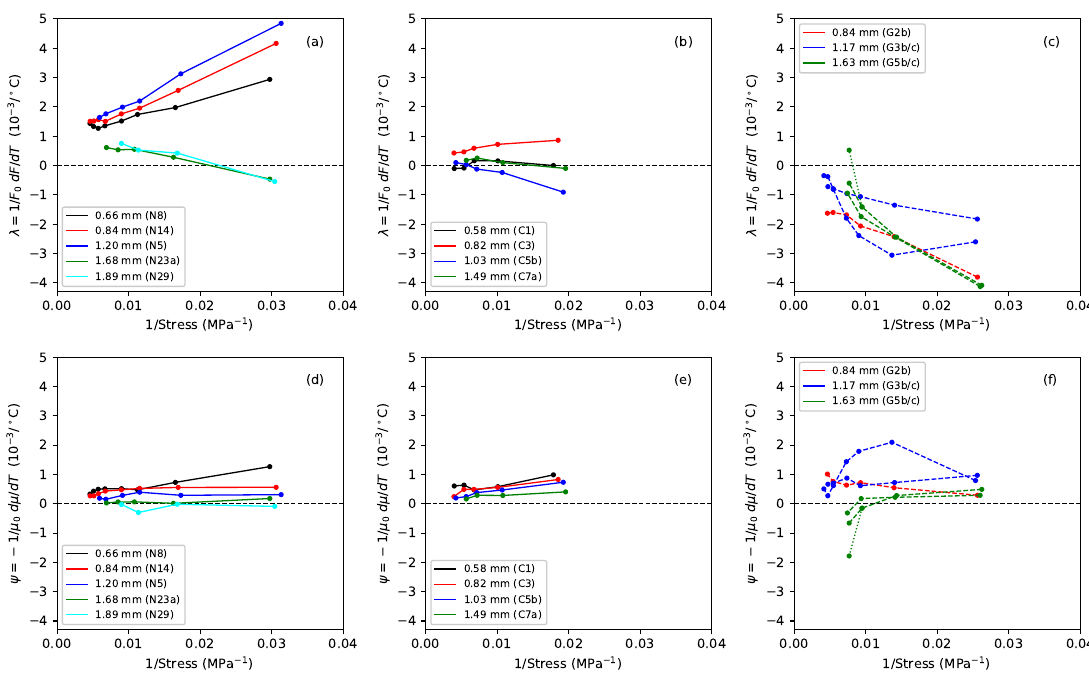
Figure 10. The thermal sensitivities in the string tension (top row) and linear density (bottom row) for the tests when the strings were held at constant length with no tuning adjustments, for ( a , d ) nylon, ( b , e ) fluorocarbon, and ( c , f ) gut. Adding these two sets of values together, and scaling by K = 600/ ln ( 2 ) , gives the thermal tuning sensitivity responses shown in Figure